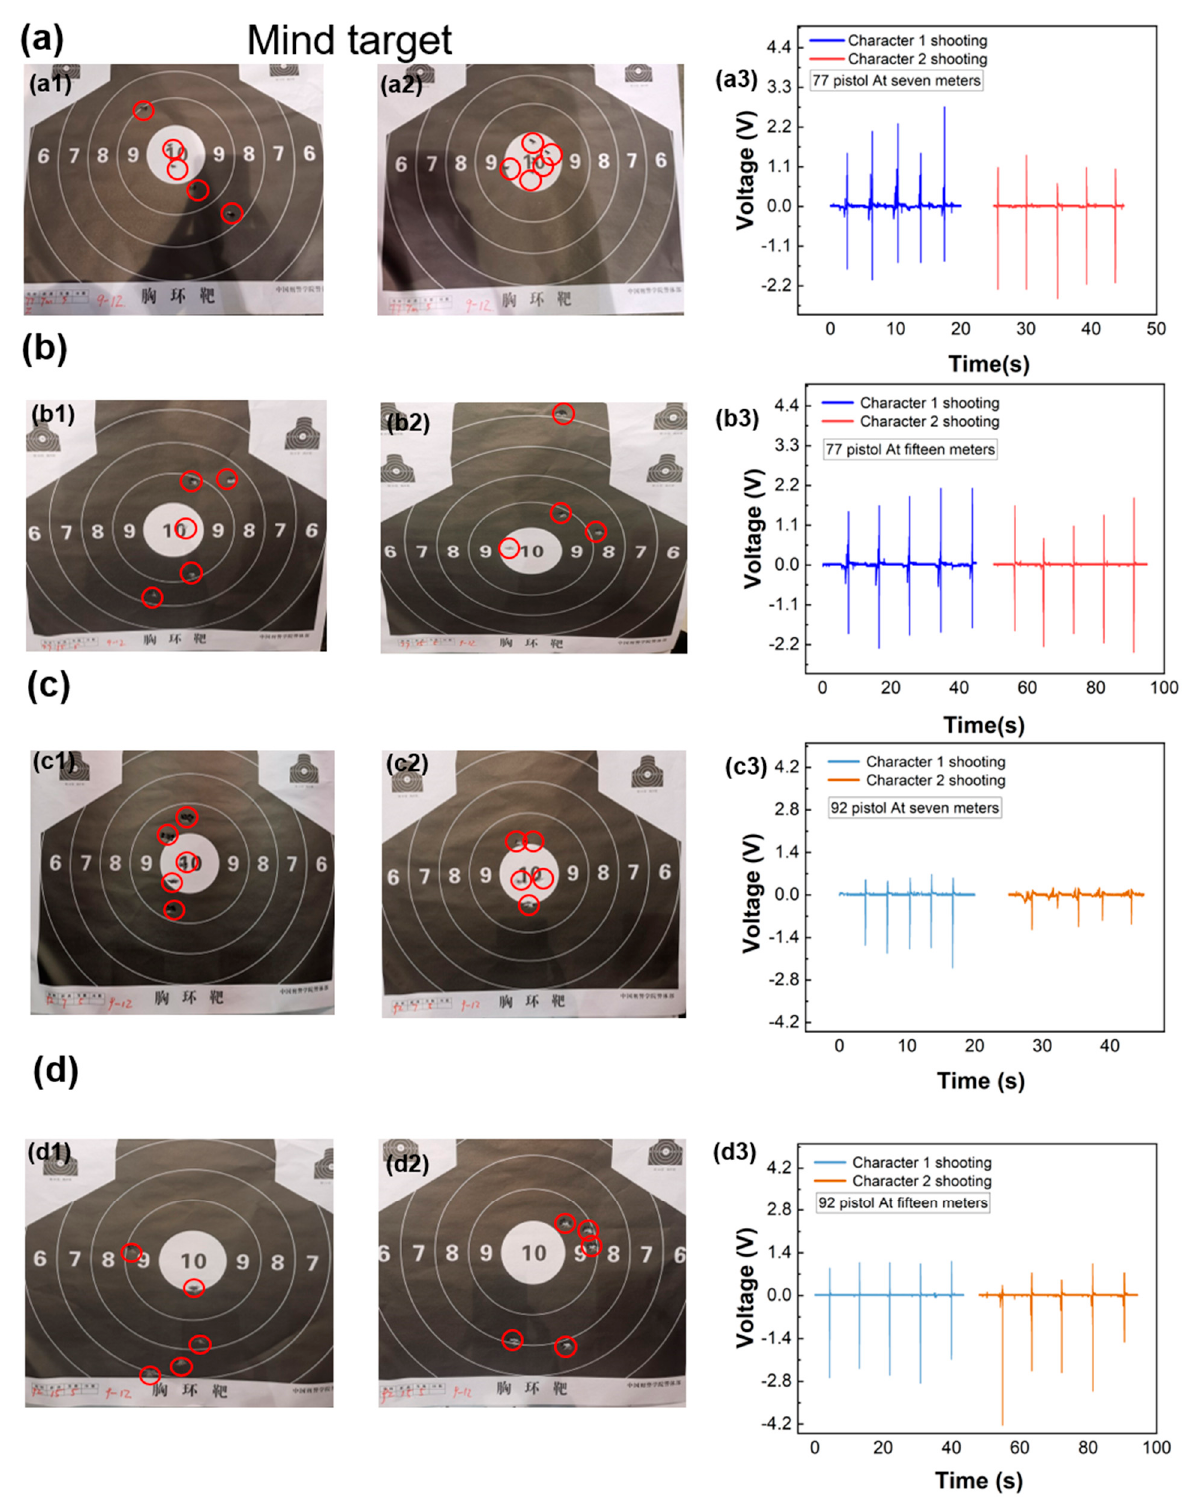
Figure 4. Actual test scene. ( a : a1-a3 ) Two testers use a 77-type pistol to shoot target bitmap and shooting monitoring signal at 7 m; ( b : b1-b3 ) Two testers use a 77-type pistol to shoot target bitmap and shooting monitoring signal at 15 m; ( c : c1-c3 ) Two testers use a 92-type pistol to shoot target bitmap and shooting monitoring signal at 7 m; ( d : d1-d3 ) Two testers use a 92-type pistol to shoot target bitmap and shooting monitoring signal at 15 m.